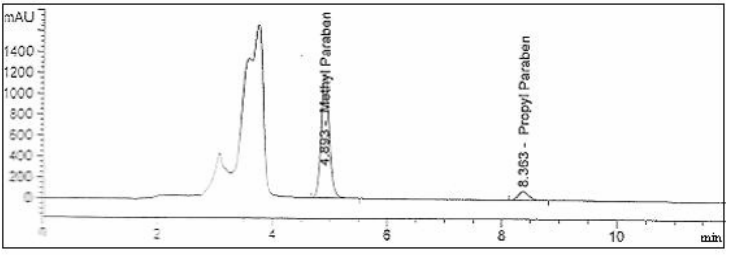
Figure 2. Method precision of methyl paraben and propyl paraben